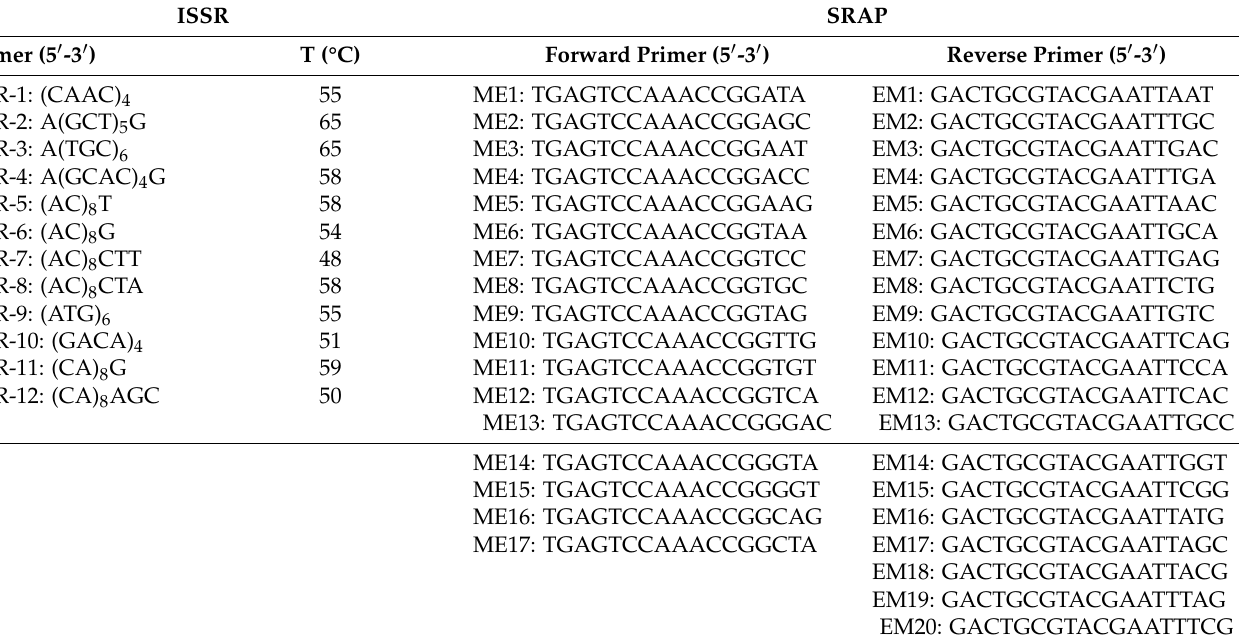
Table 2. ISSR and SRAP primers used in this study (The following 12 pairs of SRAP primers: ME3–EM11, ME3–EM12, ME4–EM7, ME6–EM7, ME7–EM5, ME8–EM13, ME9–EM14, ME9–EM17, ME10–EM6, ME17–EM10). ISSR